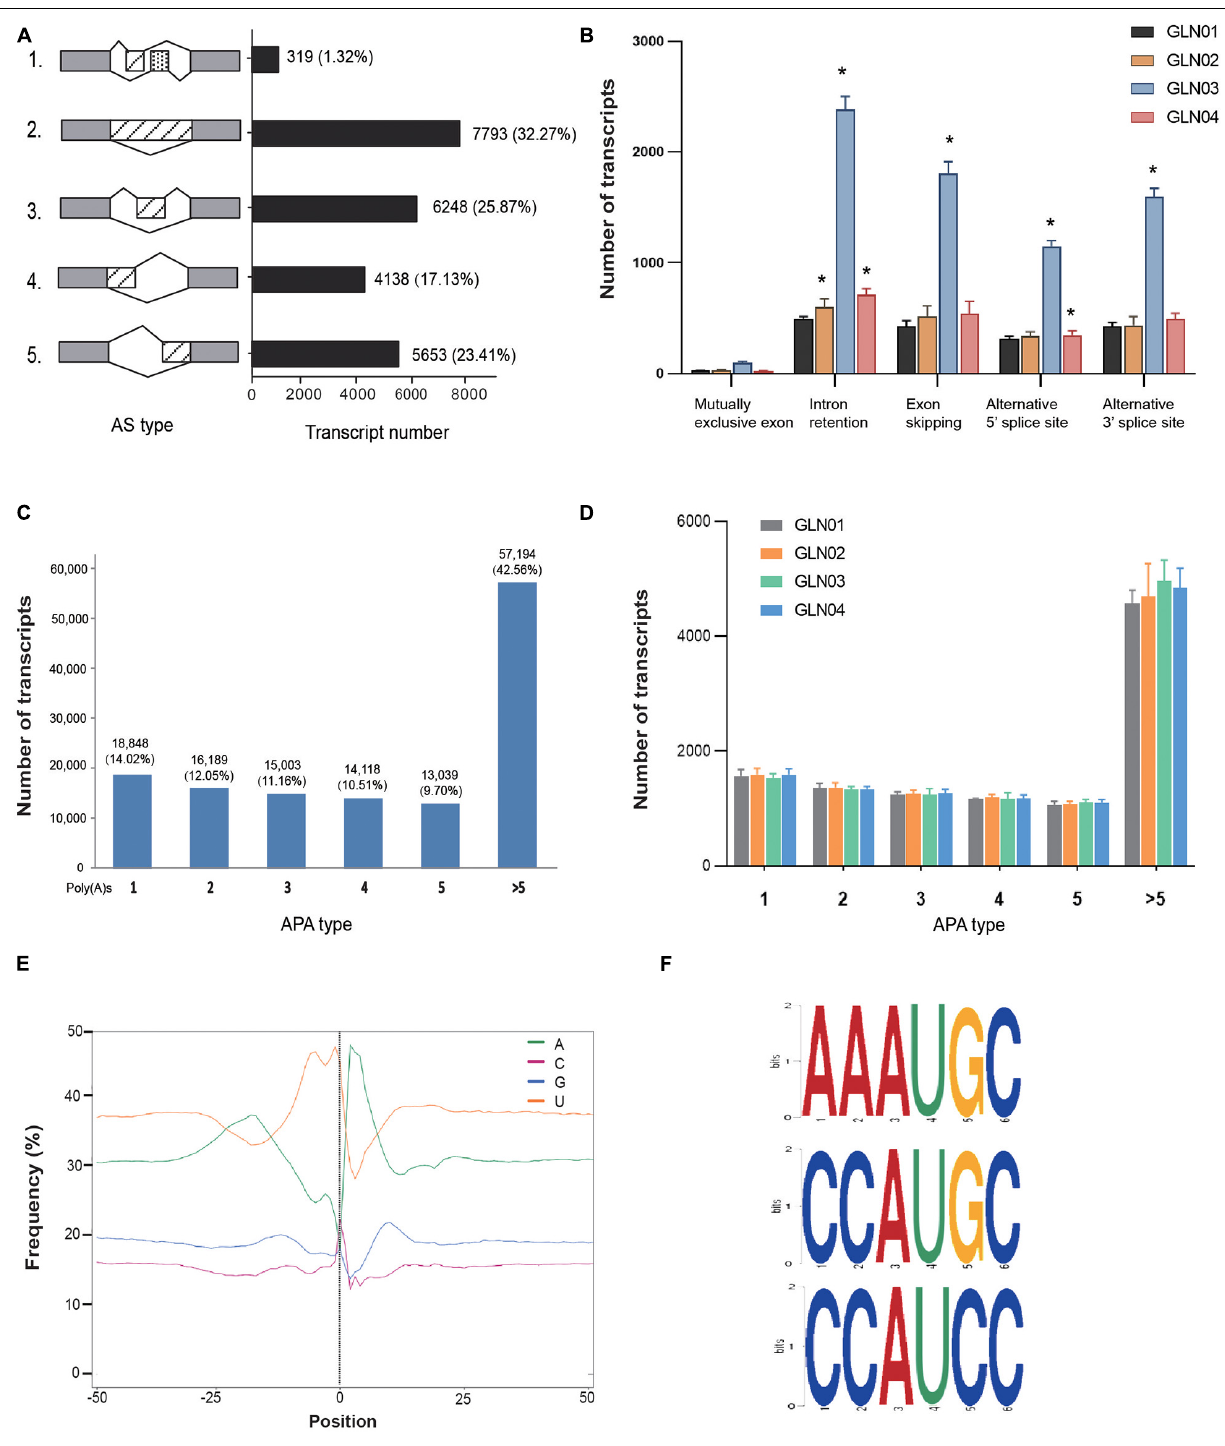
Frontiers in Genetics |